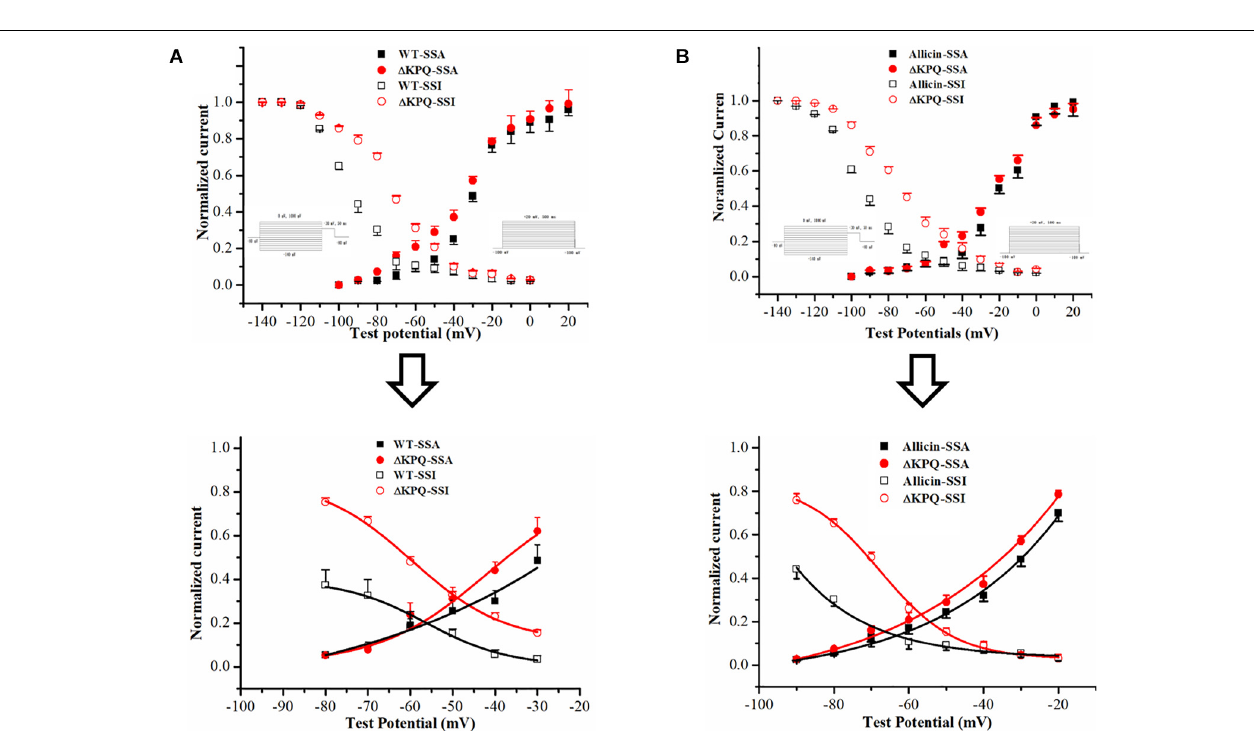
FIGURE 3 | Effect of Allicin on the window current of the (cid:49) KPQ-SCN5A mutation. (A) The window current of the (cid:49) KPQ-SCN5A mutation (the area of the red cross line) is greater than that of the WT (the area of the black cross line), which indicated that the SSI curve of the WT and (cid:49) KPQ-SCN5A mutation was different. (B) Under the effect of 30 µ M Allicin, the SSI curve was shifted to negative potentials, and the window current of the (cid:49) KPQ-SCN5A mutation was decreased.